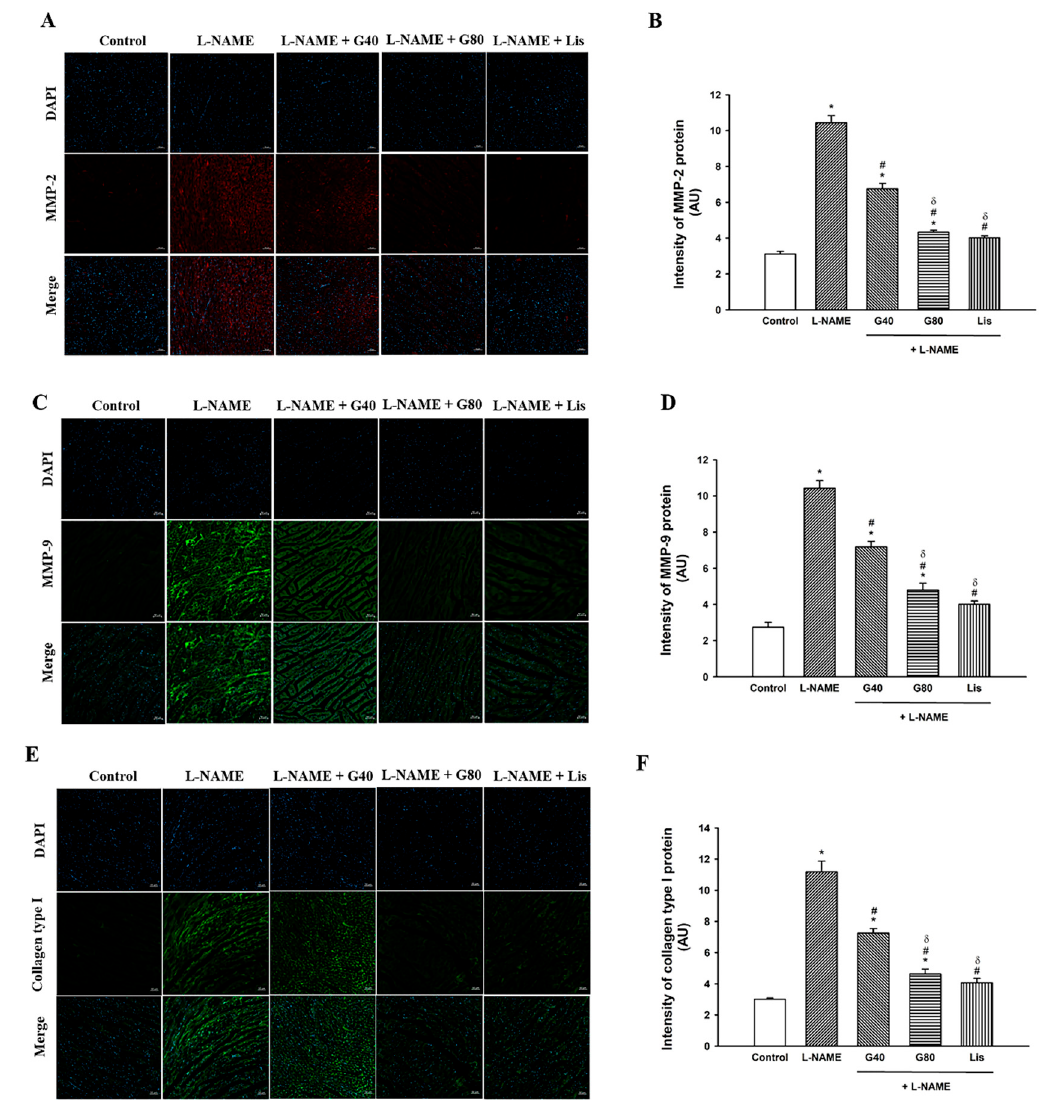
Figure 3. Representative images of immunofluorescence of MMP-2 ( A ), MMP-9 ( C ), and collagen type I ( E ) in the heart (magnification is ×10), resolution 800 dpi. Scale bar: 50 µm. Quantitative data for MMP-2 ( B ), MMP-9 ( D ), and collagen type I ( F ) in rats treated with L-NAME. Data are expressed as mean ± SEM. * p < 0.05 vs. control, # p < 0.05 vs. L-NAME, and δ p < 0.05 vs. G40 ( n = 8/group). MMP-2, metalloproteinase 2; MMP-9, metalloproteinase 9; control, normotensive rats; L-NAME, N ω -nitro-L-arginine methyl ester hydrochloride; L-NAME + G40, L-NAME hypertensive rats treated with genistein 40 mg/kg; L-NAME + G80, L-NAME hypertensive rats treated with genistein 80 mg/kg; and L-NAME + Lis, L-NAME hypertensive rats treated with lisinopril 5